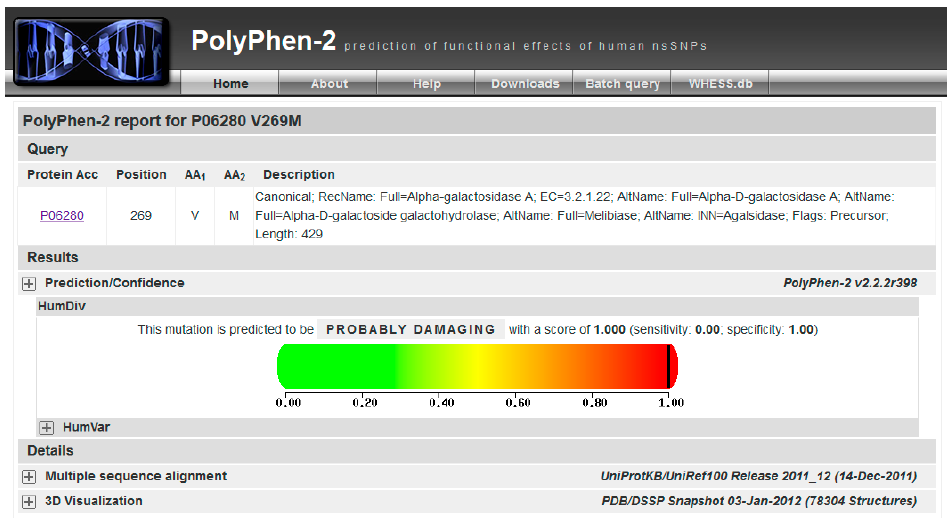
Figure 2. Alignment of the patient’s sequence with the wild-type protein sequence using BLAST. A